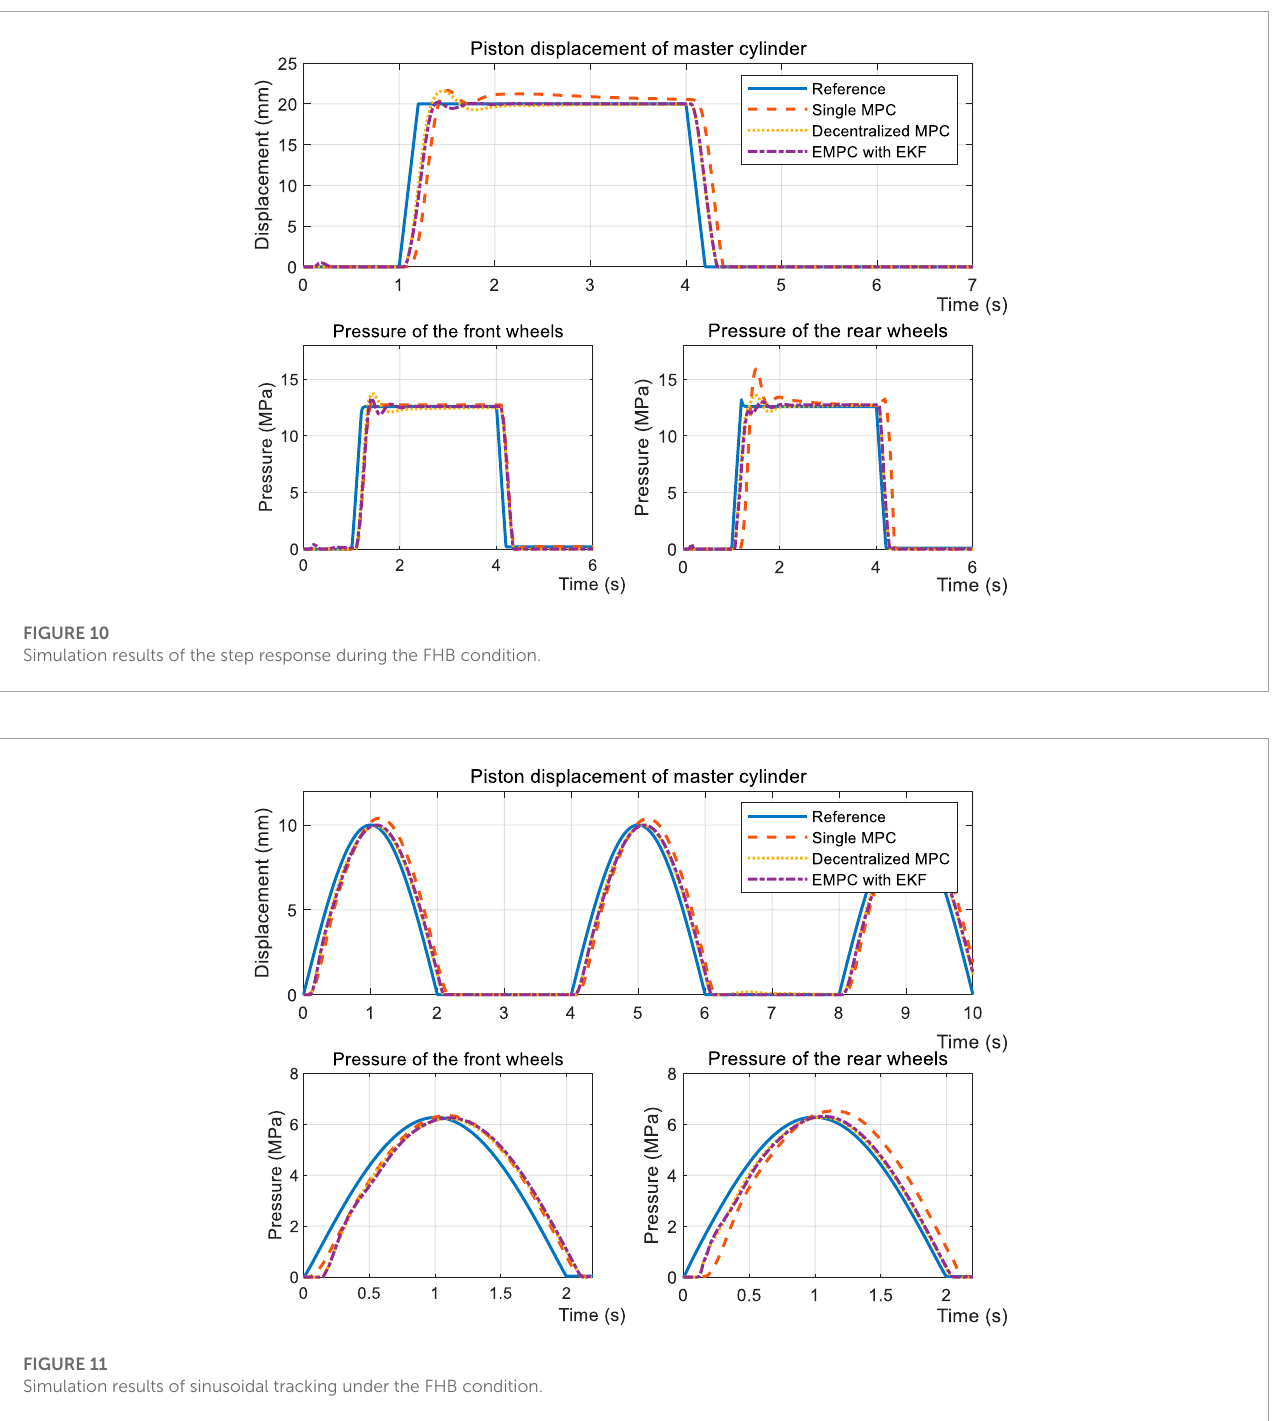
mode is switched to DEHB. The flow of the front wheels q to zero, and the rear outlet valve is used to regulate the rear wheel cylinder pressure. Similarly, in the CEHB mode, the continuously adjustable q determines the front wheel cylinder pressure, allowing iv1 for blending braking of the driving wheels. It should be noted that the volume of a low-pressure accumulator is large enough that its internal pressure is almost zero. The whole LTV plant is classified into three LTI sub- models in terms of control patterns. The state transition matrix